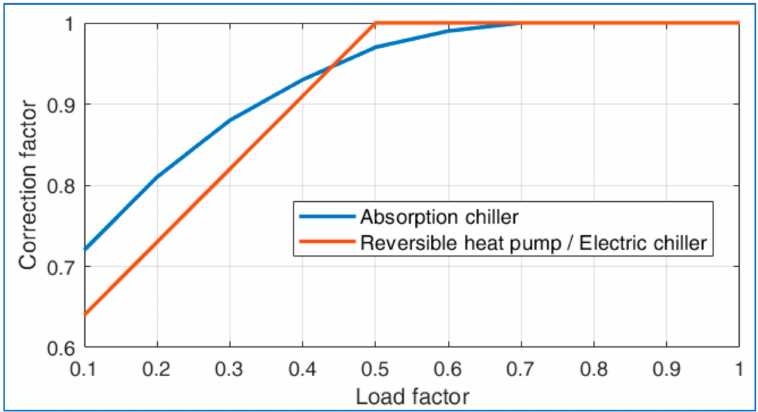
Figure 3. Part-load correction factors for the absorption chiller, reversible heat pump, and electric